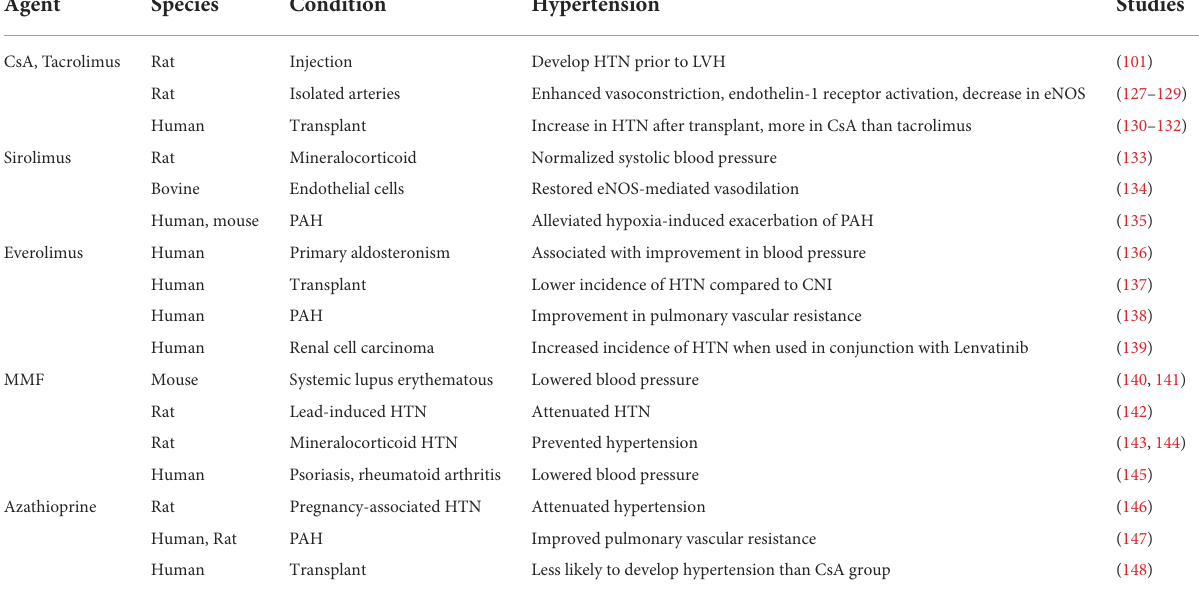
TABLE 4 Studies examining effects of immunosuppression on